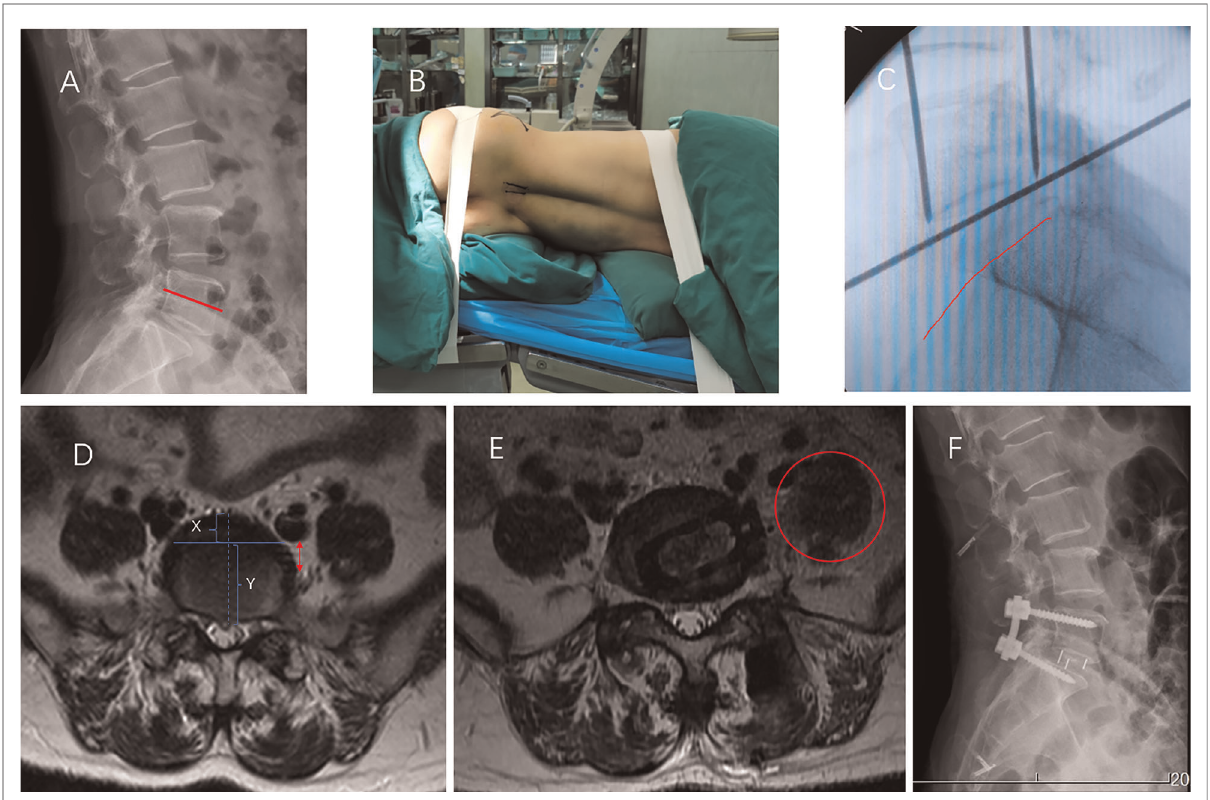
FIGURE 2 A 56-year-old woman underwent XLIF at the L5/S1 level. ( A ) Preoperative radiograph showed L5 degenerative spondylolytic spondylolisthesis, and the iliac crest was below the 1/2 line of the L5 vertebra (the red line). ( B,C ) The iliac crest ( C red line) is lowered below the L5/S1 intervertebral space after folding the operating table ( B ). ( D ) The iliac vessels were located in the fi rst quarter of the intervertebral space(X:Y<1:3). There is no obvious nerve or vascular tissue between the psoas and the lateral side of the intervertebral space. ( E ) The red circle shows the working channel through the left psoas at L5/S1. ( F ) Radiographs taken at 3 days postoperatively showed a good cage